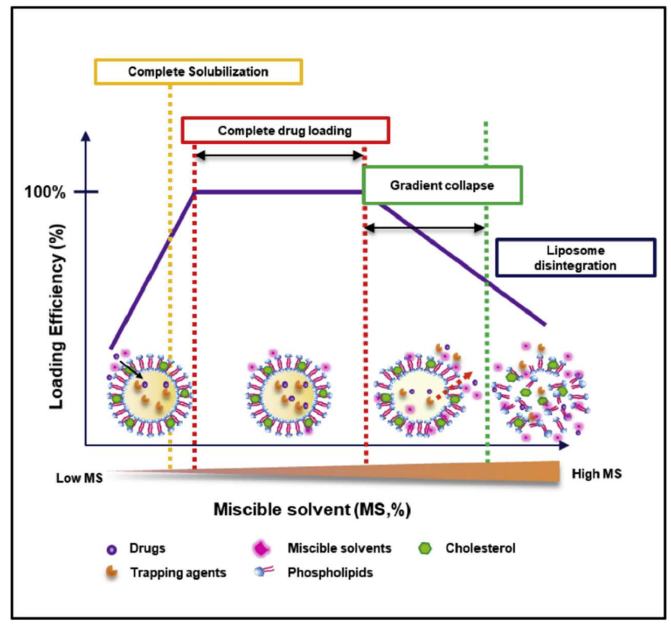
Figure 4. The solvent effect on drug loading in the SALT system . The figure is reprinted with permission from Tang et al., Biomaterials; published by Elsevier, 2018 [13].